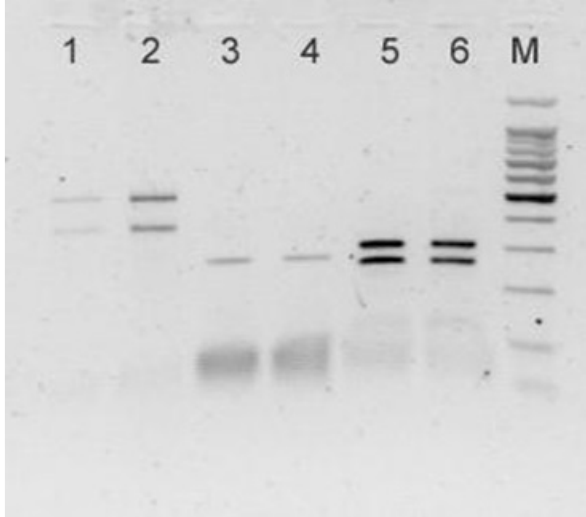
Figure 5. A representative gel displaying the Restriction Fragment Length Polymorphism profiles of C. rudolphii B obtained after digestion of ITS amplicons with endonuclease Tsp509 I (lines 1, 2) and of rrn S amplicons with Rsa I (lines 3, 4) and Dde I (lines 5, 6). M: molecular ladder 100 bp.